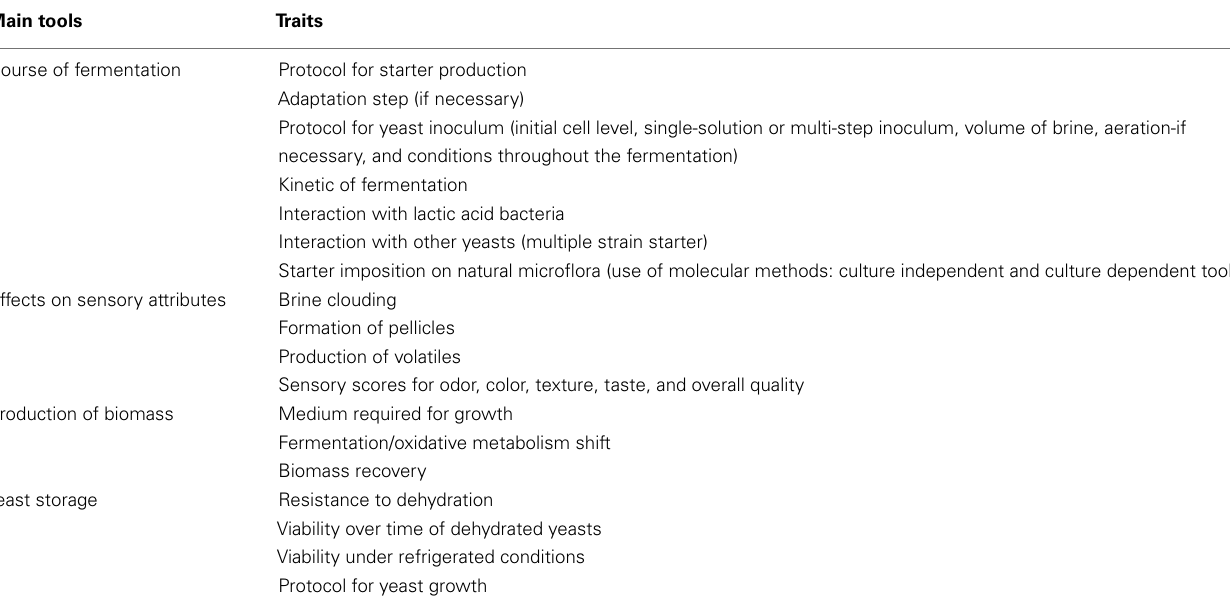
Table 4 |Tools for yeast validation in table